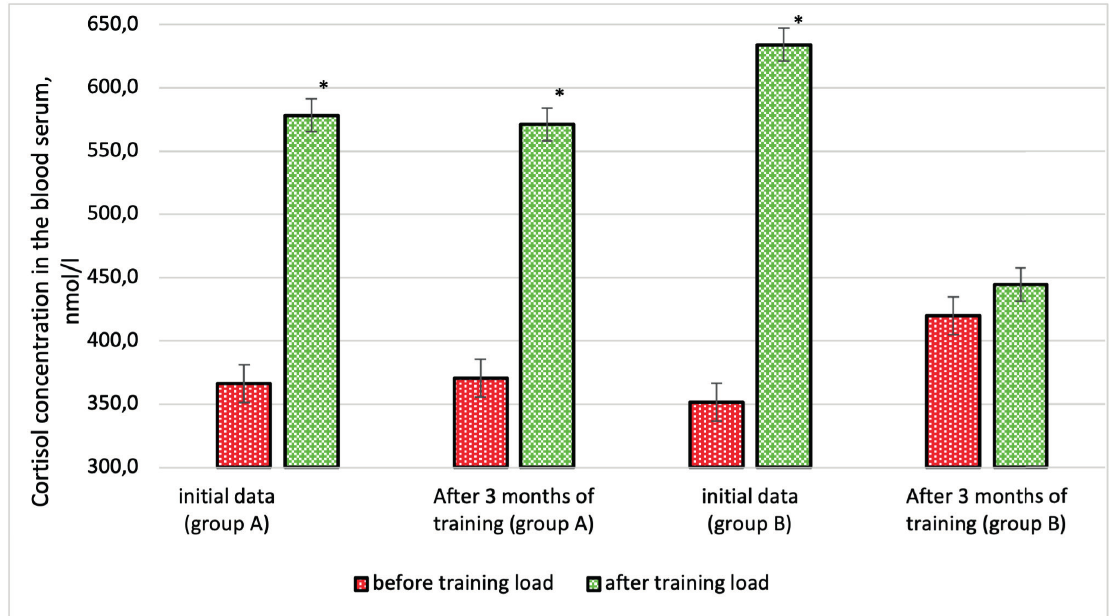
Fig. 2. Change in the concentration of cortisol in the blood serum of group A ana B female athletes during the research, n = 36. Note: * - p <0.05, compared to the indicators before training